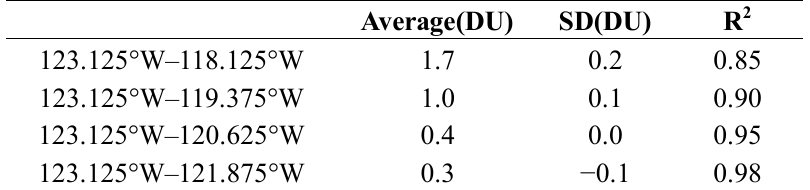
Table 2. Statistical parameters of TOC differences between the westernmost latitude (118.125°W) and the other bands for the period 1978–2013 in the Yangtze River